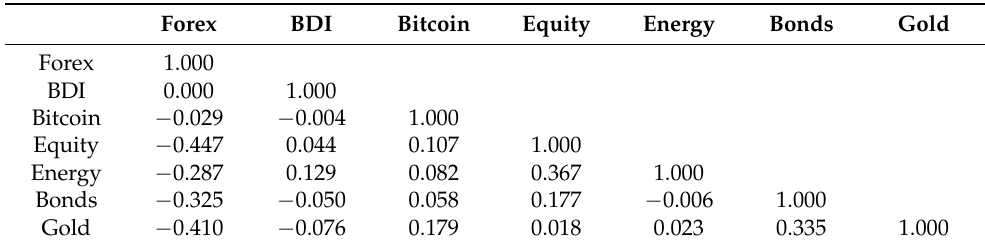
Figure 2. Normalized price development (all assets). Table 3. Correlation matrix of asset returns.